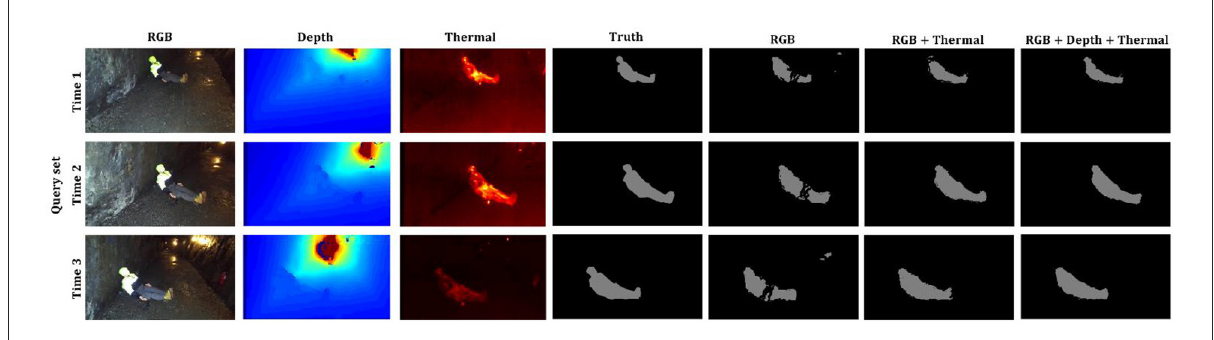
FIGURE3 The visualization of real-time target segmentation output through each modality with ResNet50 backbone and M2CE